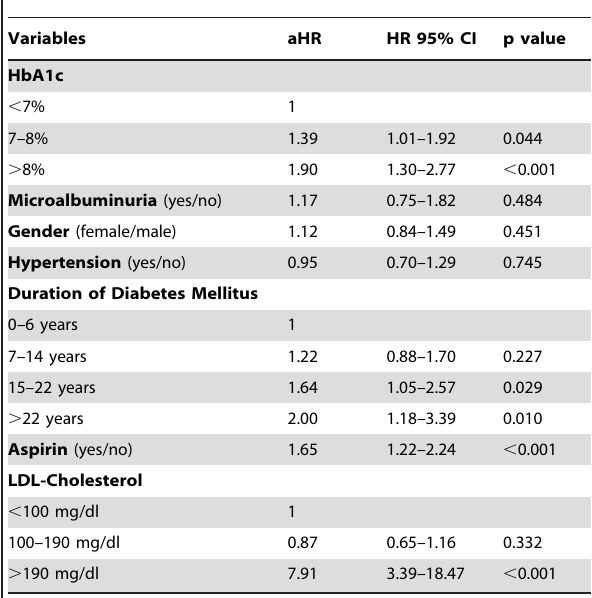
Table 3. Associated Risk Factors for Incident Diabetic Retinopathy (n= 194) after four-year follow-up of 2,405 patients (Multivariable Cox